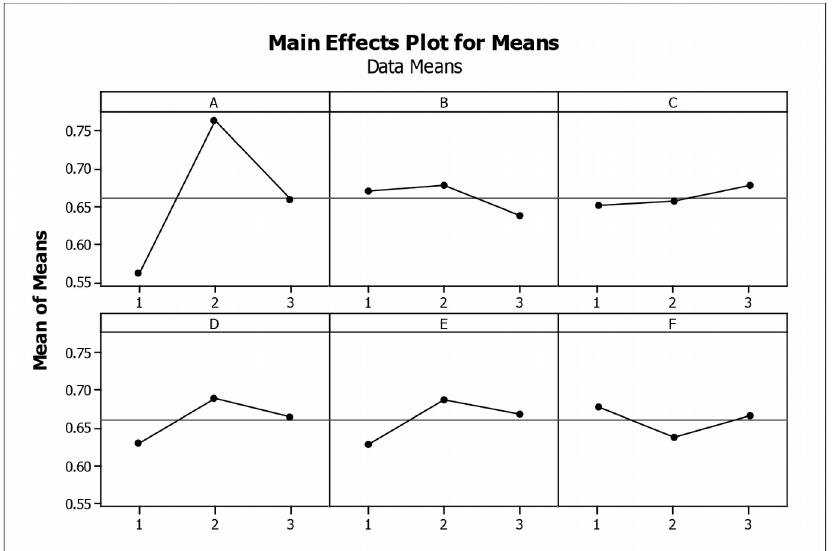
Figure 11. Average RPD for each level of the